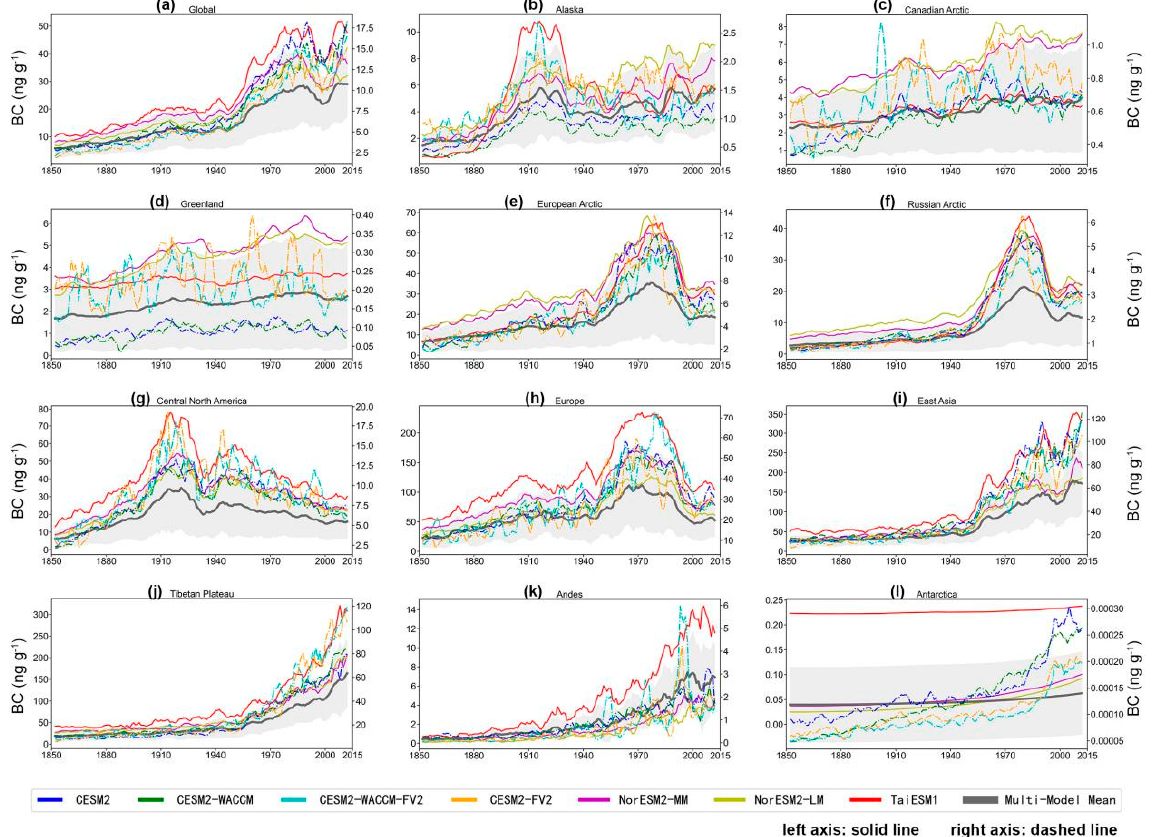
Figure 3. Temporal trends (1850–2014) in yearly BC concentrations in snow (BCS) from multi-model mean and individual models, globally ( a ) and regionally ( b – l ). Gray lines represent multi-model mean BCS; other colors represent individual model results. The inter-model standard deviation is shown by gray shading. Data were processed with five-point smoothing. Values for solid lines are on the left axis and those for dashed lines on the right.